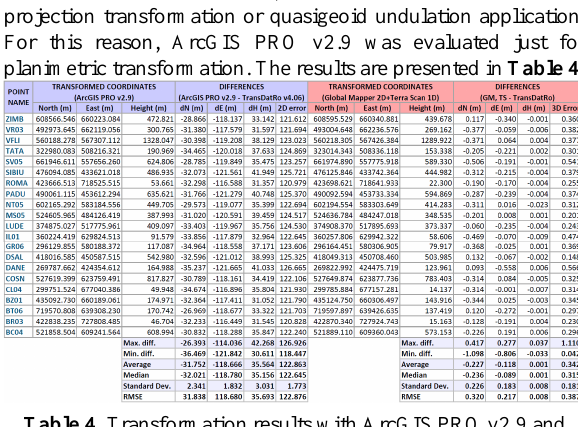
Table 4 . Transformation results with ArcGIS PRO v2.9 and Global Mapper v23.0 combined with TerraScan